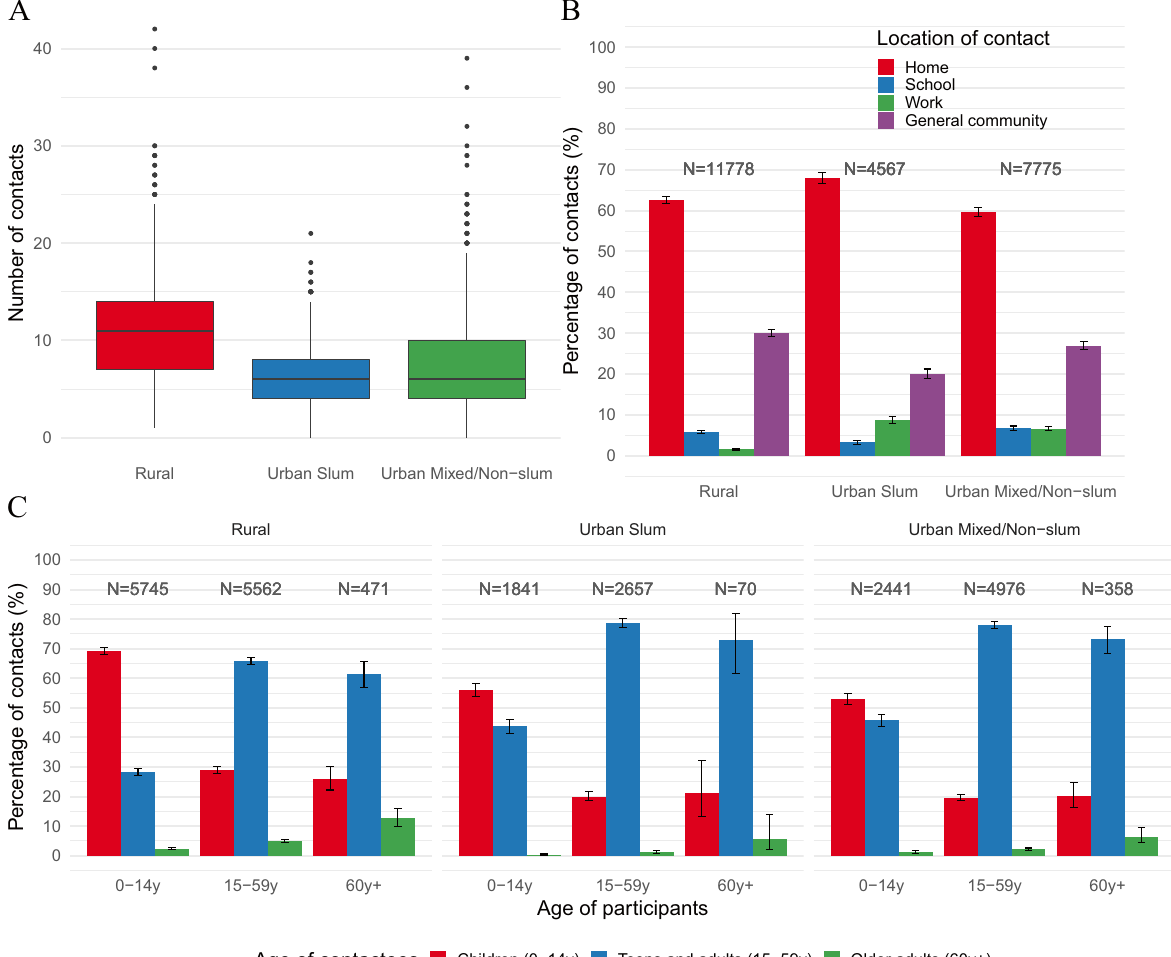
Figure 2. Distribution of daily social contacts by setting ( A ), percentage (with 95% CI) of daily social contacts by location of contact ( B ), and percentage (with 95% CI) of daily social contacts by setting and age of participants with children (0–14 years), teens and adults (15–59 years) and older adults (60+ years) ( C ). For each bar, the respective denominator (N) is reported. All CIs are computed as Wilson CIs for a binomial proportion 42